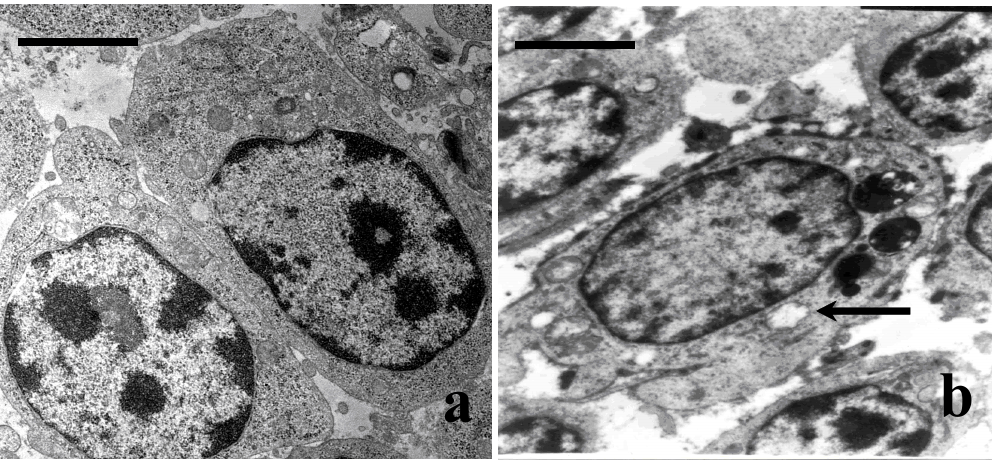
Figure 2. The ultrastructural changes of bursae at 42 days of age. ( a ) The lymphocytes in the control group. ( b ) The mitochondria of lymphocytes are swollen or vacuolated with degenerating cristae ( right arrow ) in Met-deficient birds (Bar = 2 μm).